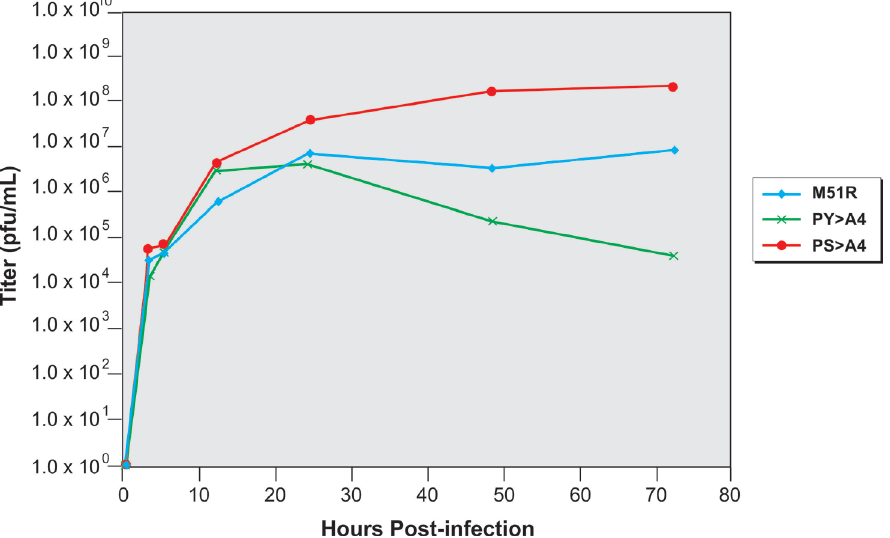
Figure 5. Growth curves in mosquito C6/36 cells. Mosquito C6/36 cells were infected with M51R (blue), PY > A4 (green), or PS > A4 (red) at an MOI of 50, and virus released into the supernatants at the times indicated was harvested and quantified by standard plaque assay on BHK-21 cells. A representative growth curve is shown.